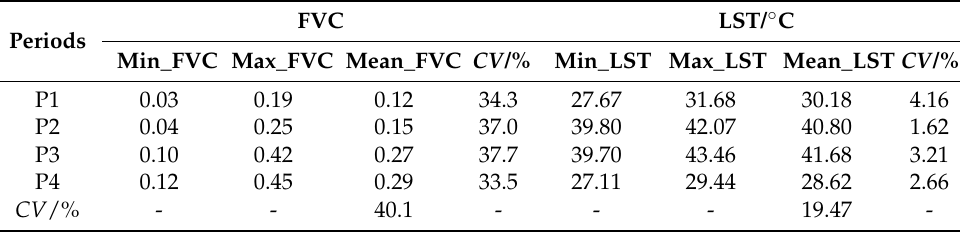
Table 5. Basic characteristics of FVC and LST in S1–S12 sample area at